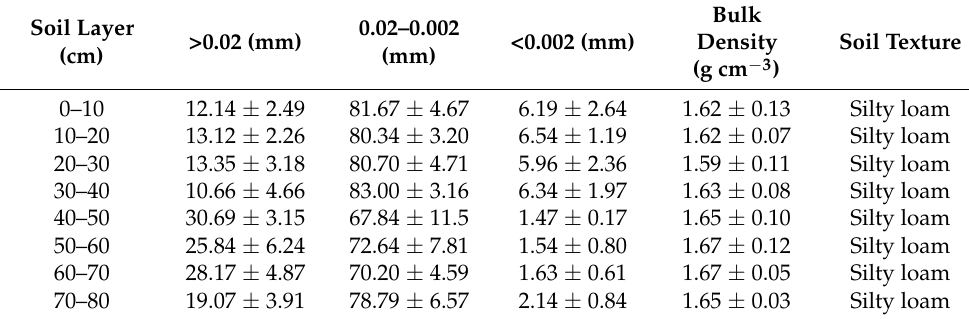
Table 3. Soil particle size distribution and bulk density in the